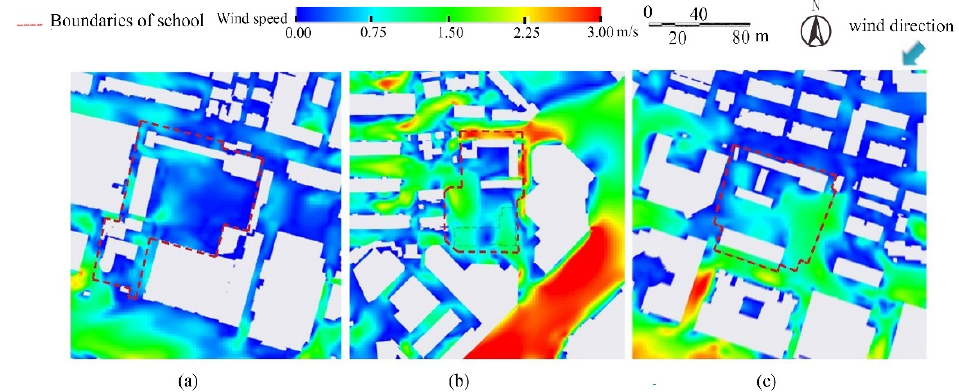
Figure 8. Wind speed distributions at the pedestrian level in three primary schools in winter in the 2010s: ( a ) Changjiang Road Primary School; ( b ) Chibi Road Primary School (Shanxi Road Campus); ( c ) Jianye Road Primary School.